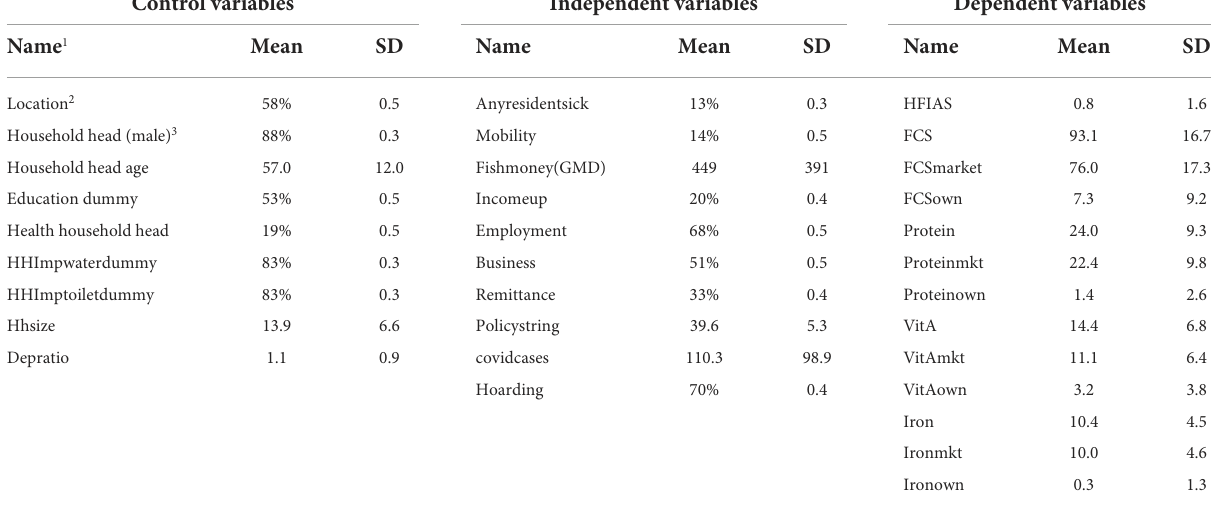
TABLE 8 Variable data for regression